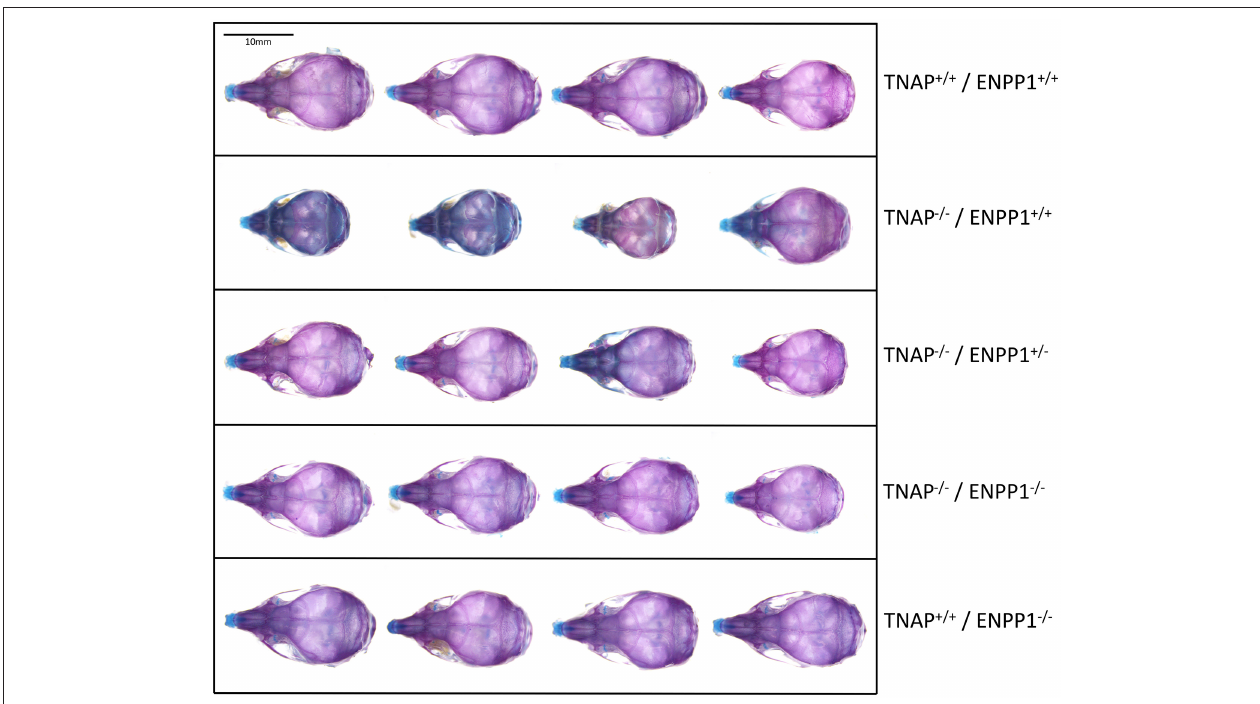
FIGURE 1 | Skull phenotype is rescued by ablation of ENPP1 In TNAP deficient mice. Representative alizarin red and alcian blue stained skulls of each genotype are shown. Note the variable hypomineralization seen in TNAP null (TNAP − / − /ENPP1 + / + )